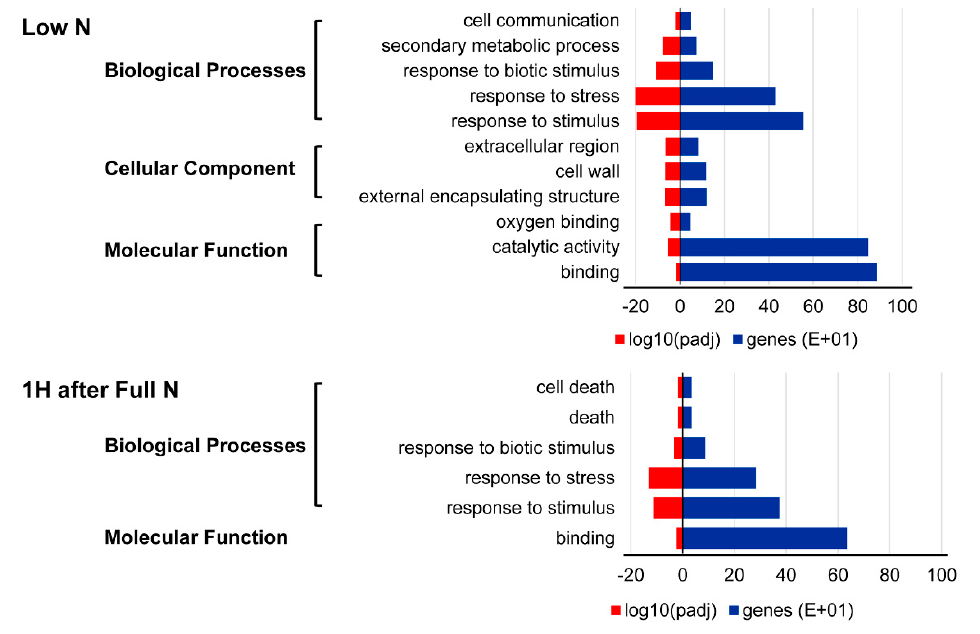
Figure 7. Gene ontology of DEGs from low N and 1-h recovery treatments in Pokkali and Bengal.